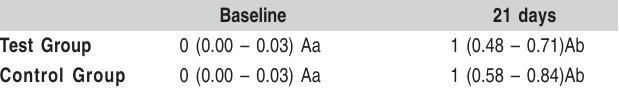
Table 2 – Gingival Index values (median (95% confidence interval)), before and after use of control and test solutions.